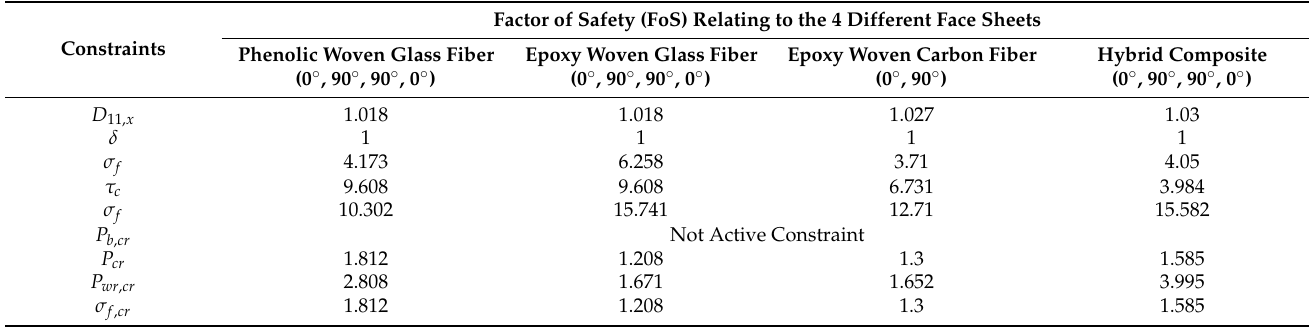
Table 7. Safety factors for design constraints of helicopter floor sandwich plates. Factor of Safety (FoS) Relating to the 4 Different Face Sheets Constraints